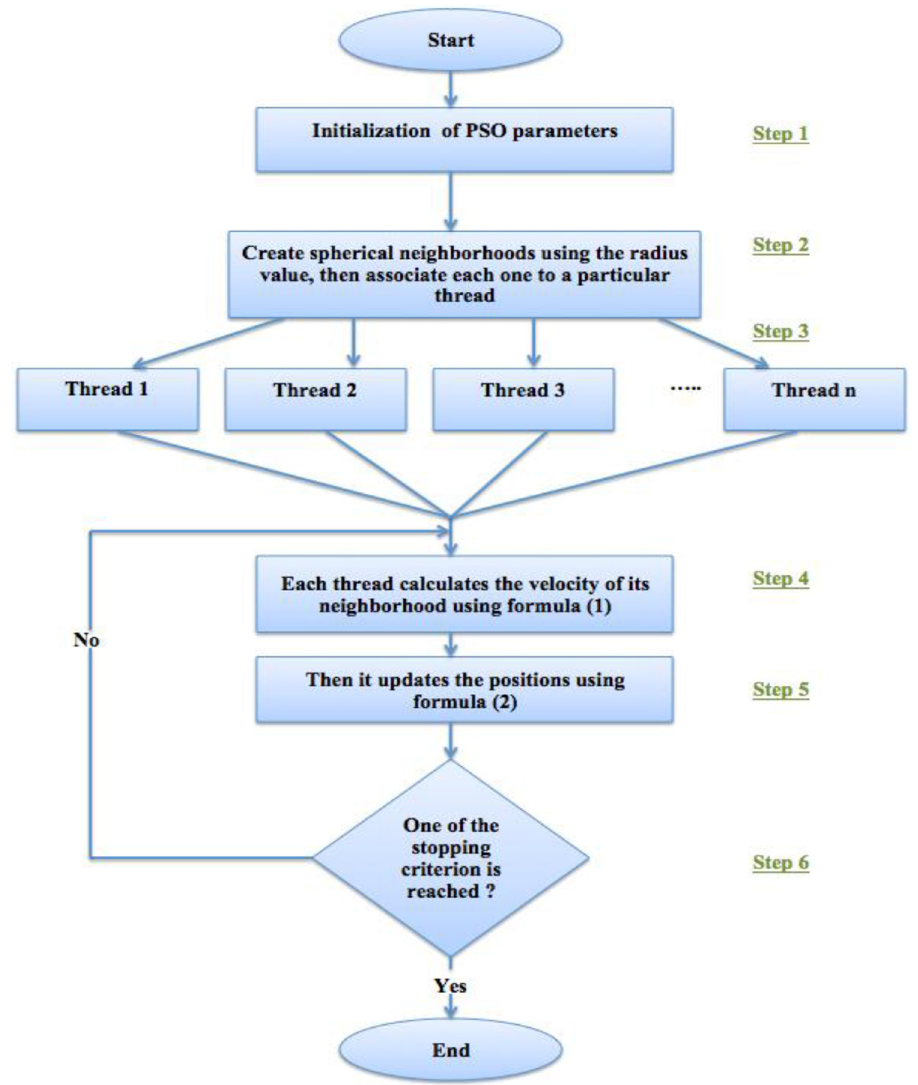
Fig. 6. SPM algorithm fl